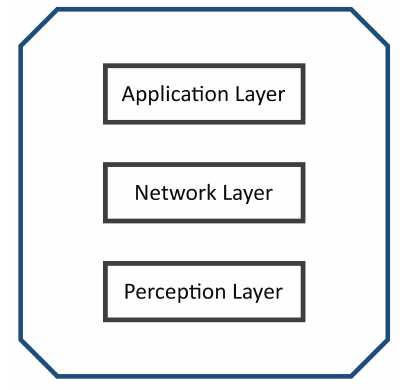
Figure 2. Illustration of basic IoT architecture.